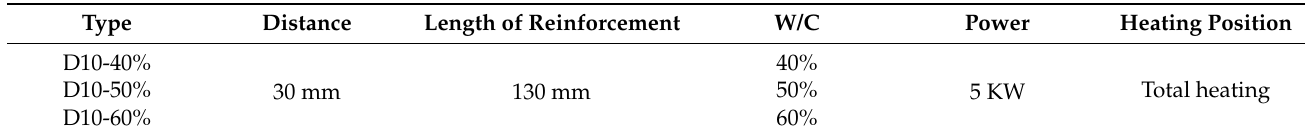
Table 8. Experimental Factors.